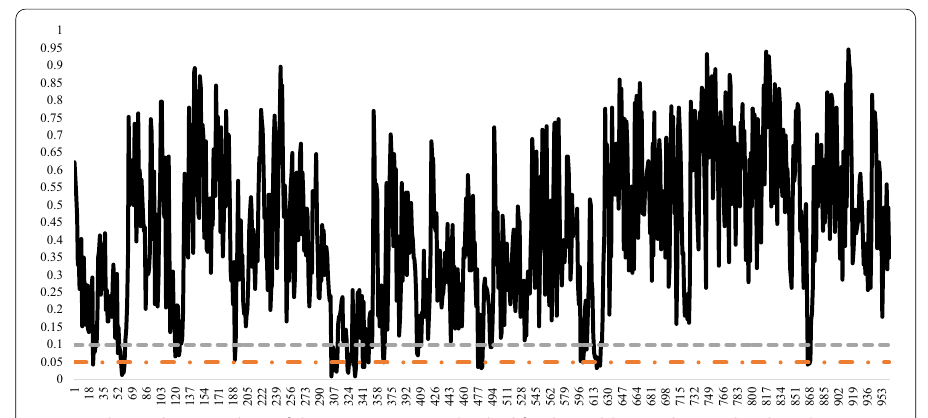
Fig. 29 The evolving p values of the GS test statistic checked for the Gold in 50-day window length